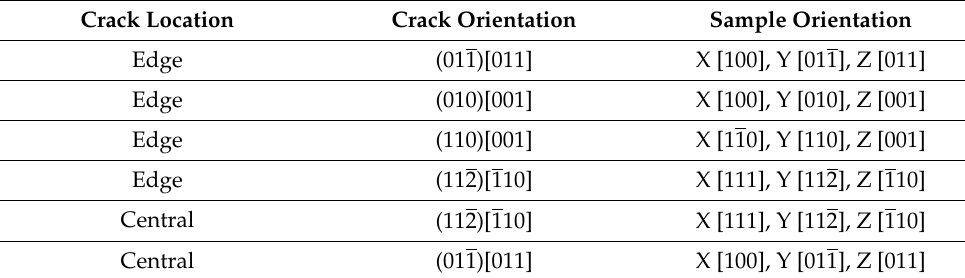
Figure 1. Loading scheme for samples with an edge ( a ) and a central ( b ) crack. Table 1. Simulated